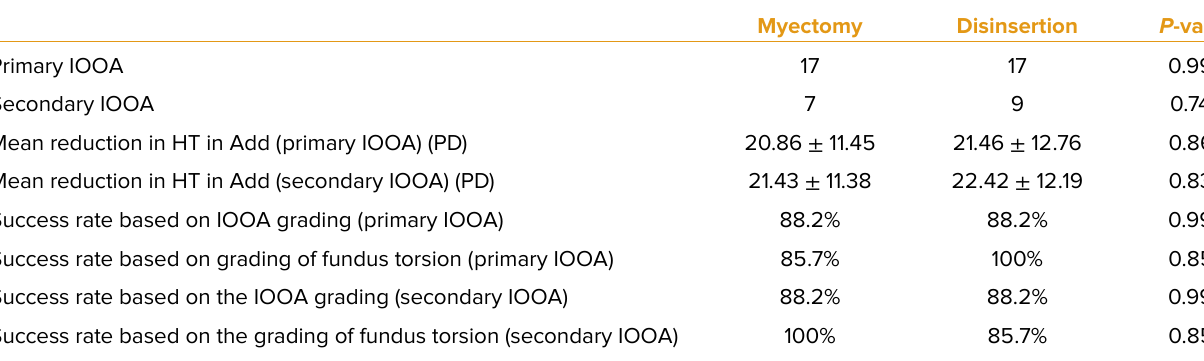
Table 4. Comparison of myectomy and disinsertion in the subgroups of primary and secondary IOOA